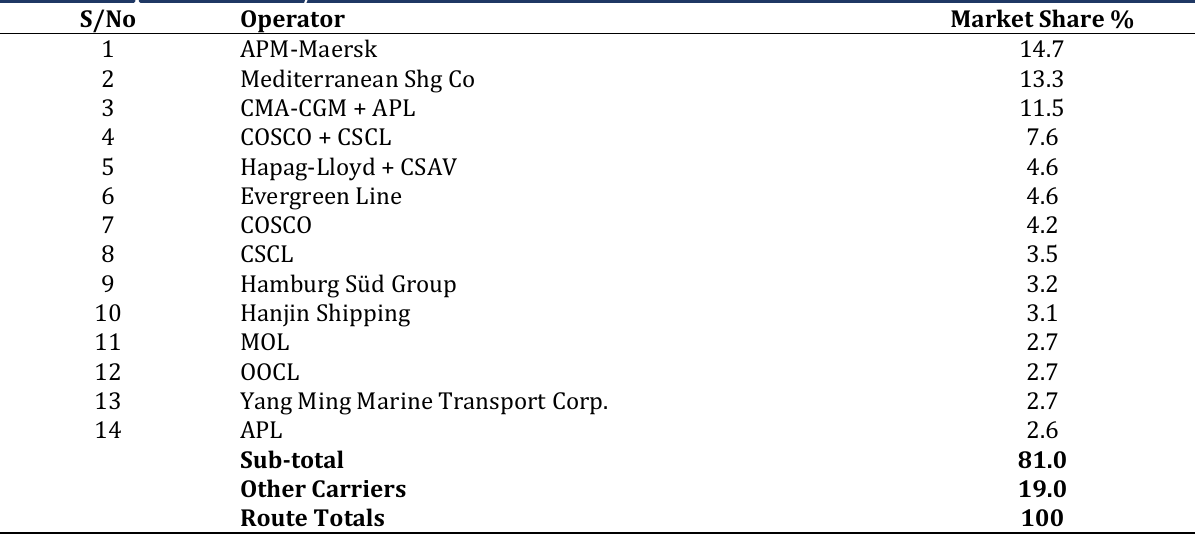
Table 1: Deep Sea Alliances/ Carriers Market Share S/No